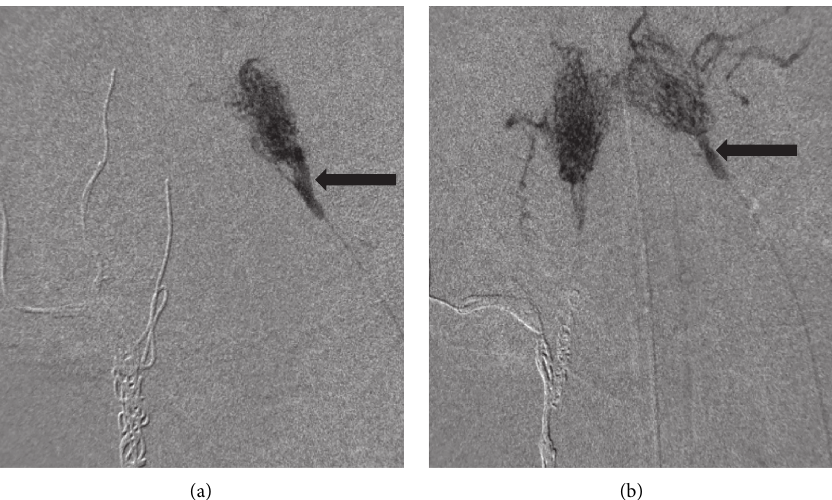
Figure 1: Embolization of the AVM model (group 1; n � 2). Black arrows corresponding to the tip of the microcatheter: (a) embolization with S18 ® alone ( n � 1) (embolization limited to only one rete mirabile corresponding to half of the nidus AVM model); (b) embolization with AS18 ( n � 1) (embolization of both rete mirabile corresponding to the whole nidus AVM model).